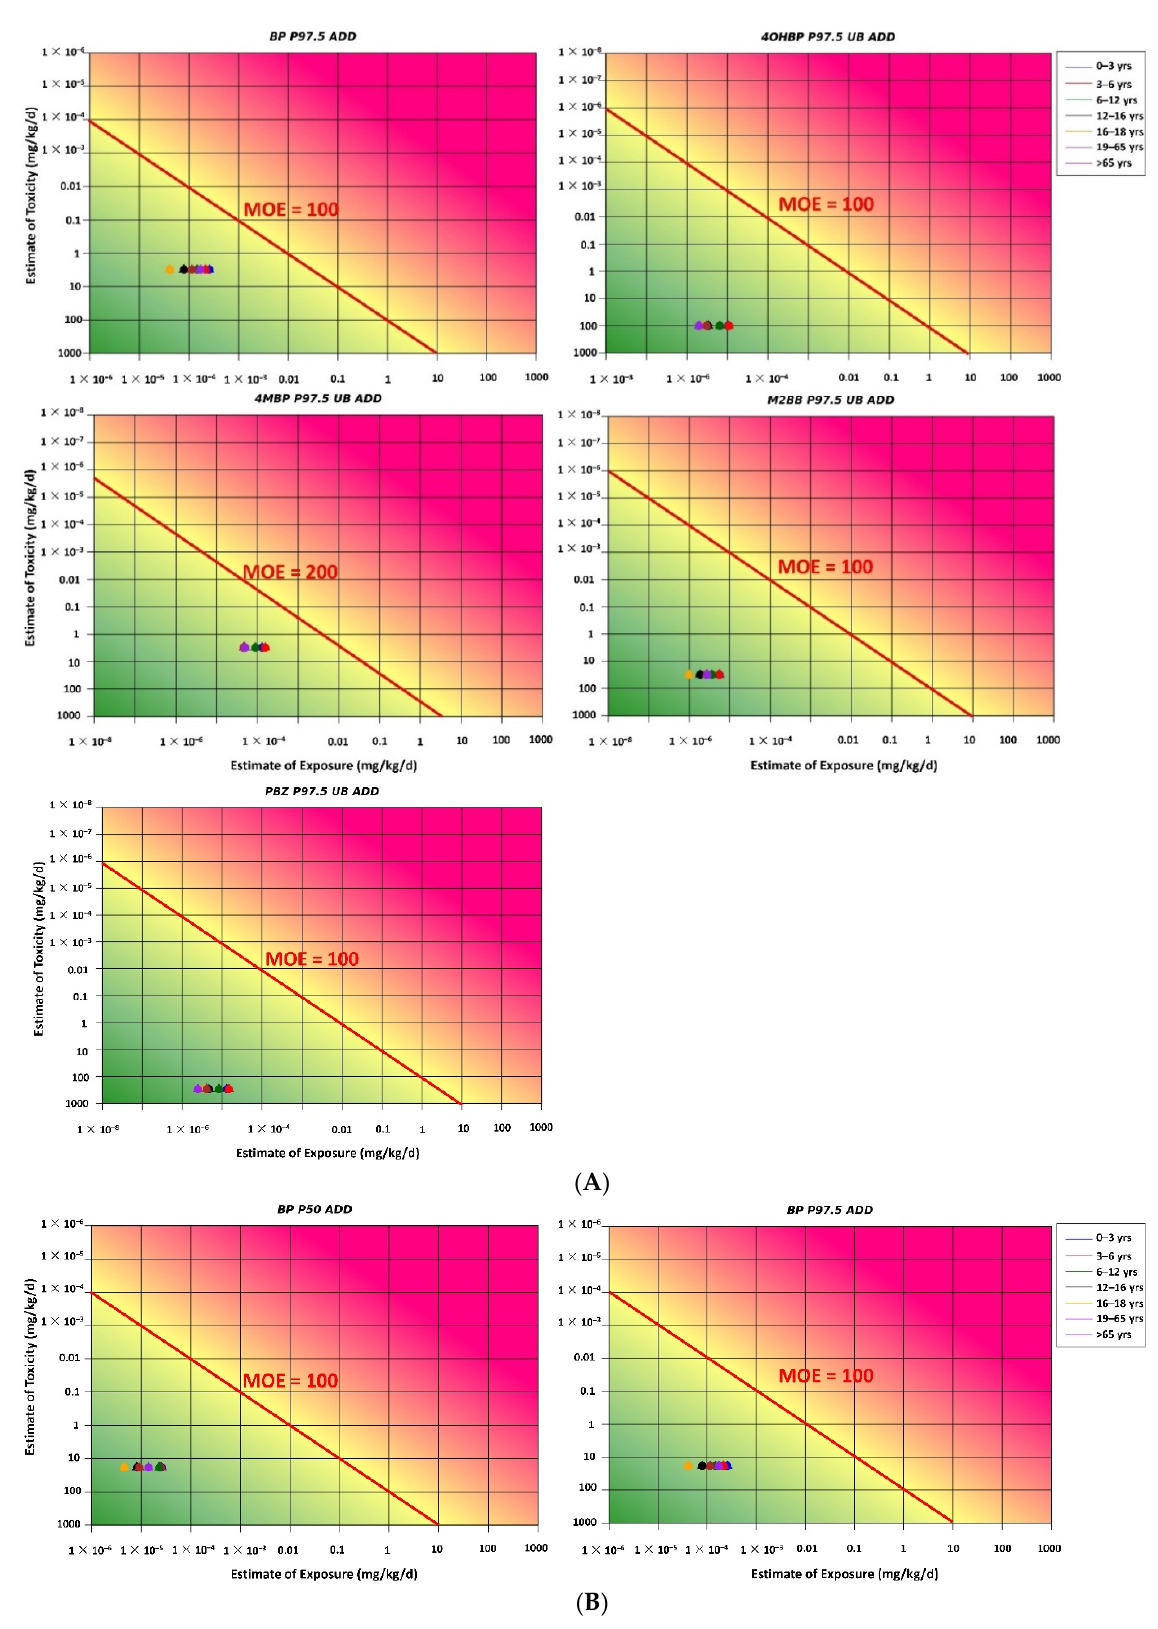
Figure 4. ( A ) Noncarcinogen risk in different age groups determined using the RISK21 matrix (scenario 2). ( B ) Carcinogen risk in different age groups determined using the RISK21 matrix (scenario 2).